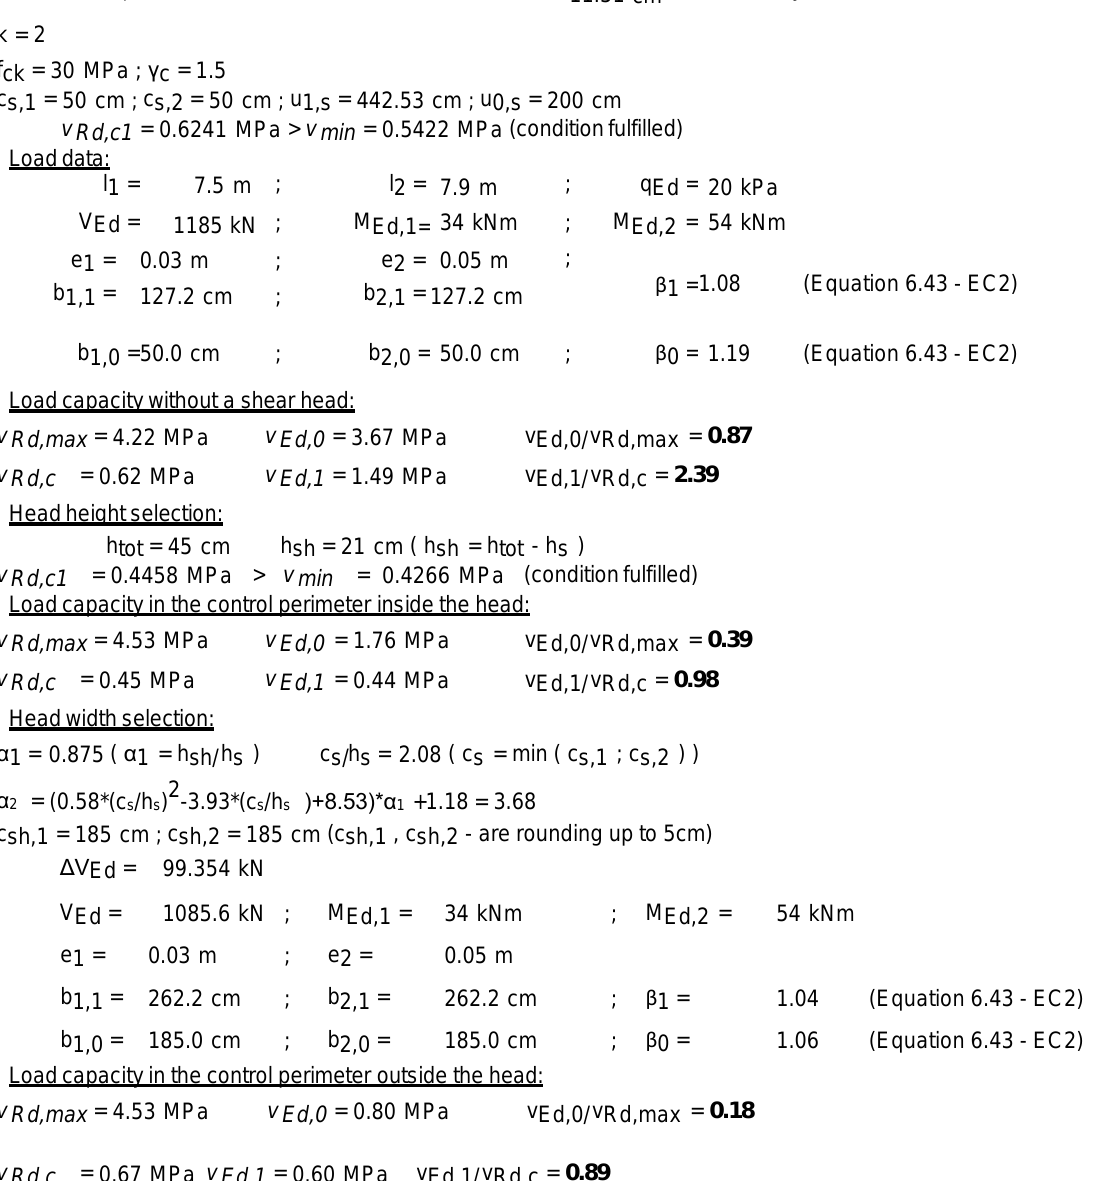
Figure A1. Verification example no. 1—EC2.